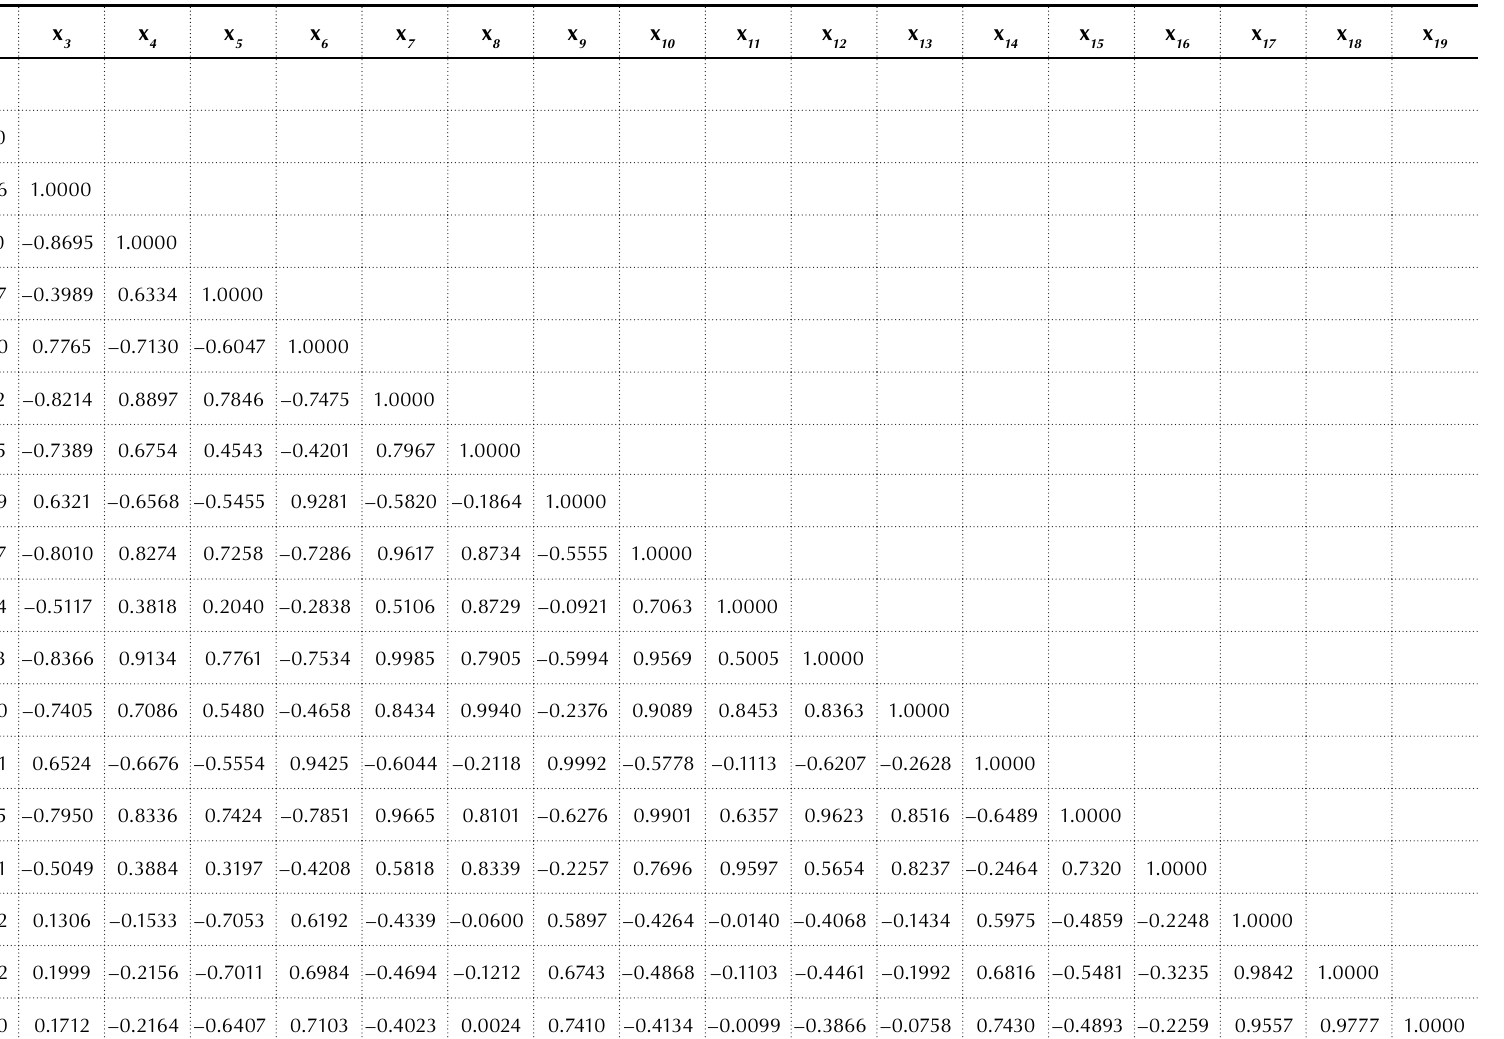
Source: Calculated by